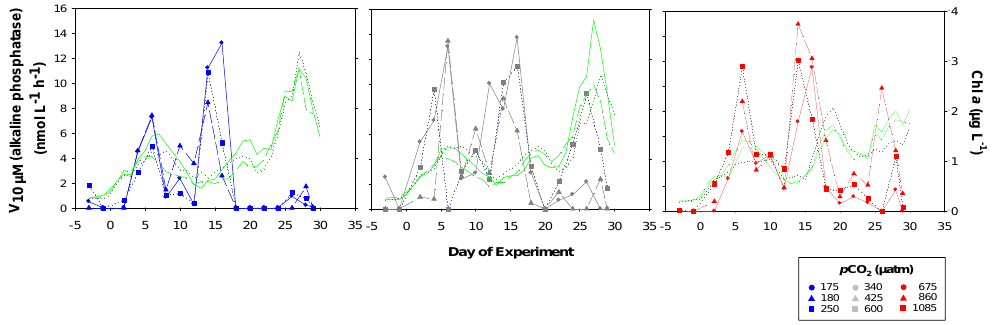
Fig. 8. Temporal development of extracellular phosphatase activity in mesocosms of low (175–250µatm; blue symbols), medium (340– 600µatm; grey symbols) and high p CO 2 (675–1085µatm; red symbols). Reaction velocities at 10µmolL − 1 substrate concentration ( V 10 µ M ) are normalised to volume (nmolL − 1 h − 1 ) . Green lines represent chlorophyll a (Chl a) concentrations in the mesocosms.